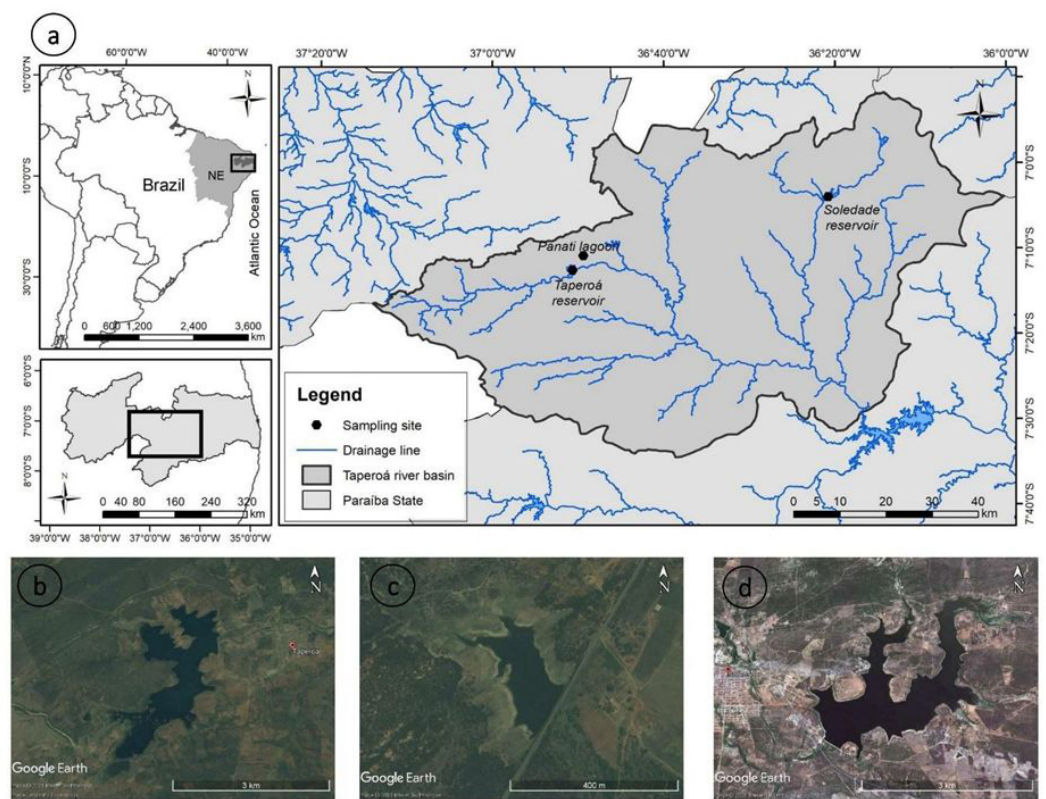
Figure 1. (a) Localization of the Taperoá river basin (Paraíba State, Brazil) and the three aquatic ecosystems studied; satellite images (Google Earth Pro Platform) of the (b) Taperoá reservoir, (c) Panati lagoon and (d) Soledade